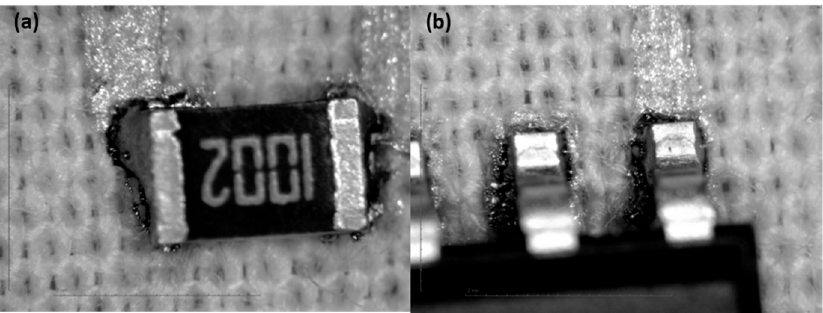
Figure 15. Soldering microscope pictures of 0805 ( a ) and SOIC8 ( b ) packages with solder paste SRA SSLTNC.